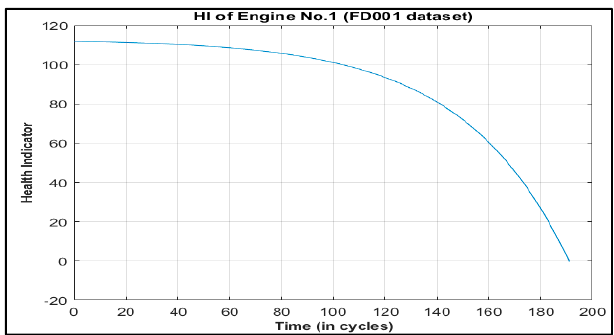
Figure 1. Health indicator of engine no. 1 of FD001 dataset.